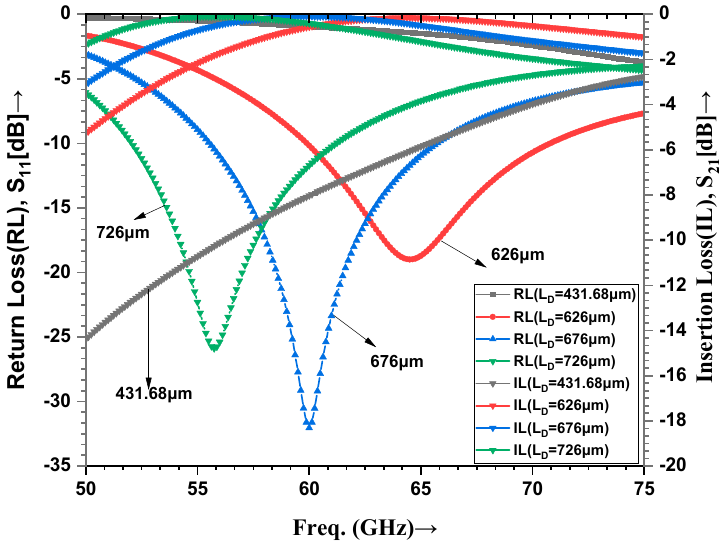
Figure 4. Effect of variations of dipole antenna length on RL and IL plots. Table 3. Dipole antenna arms’ length